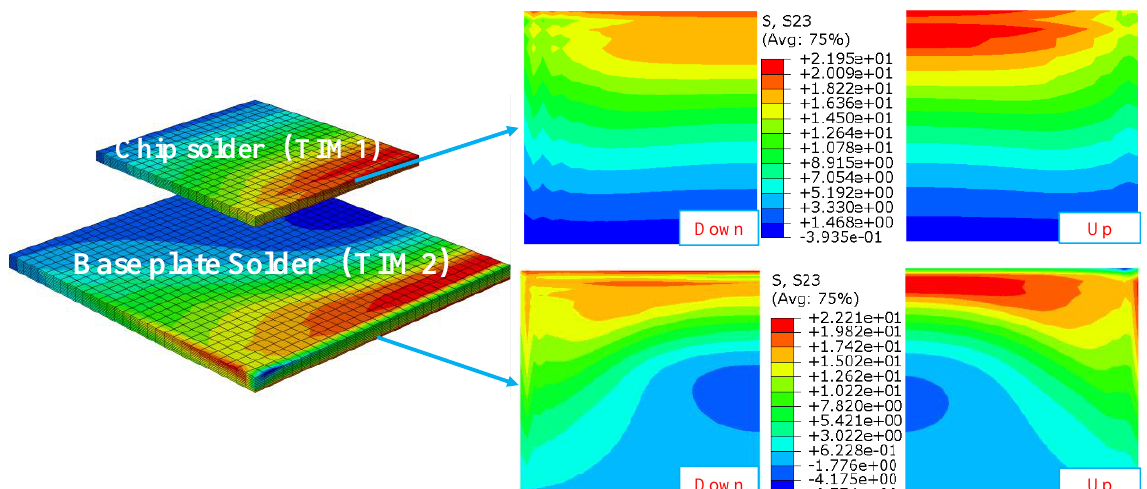
Figure 9: Shear stress distribution in the solder layer.